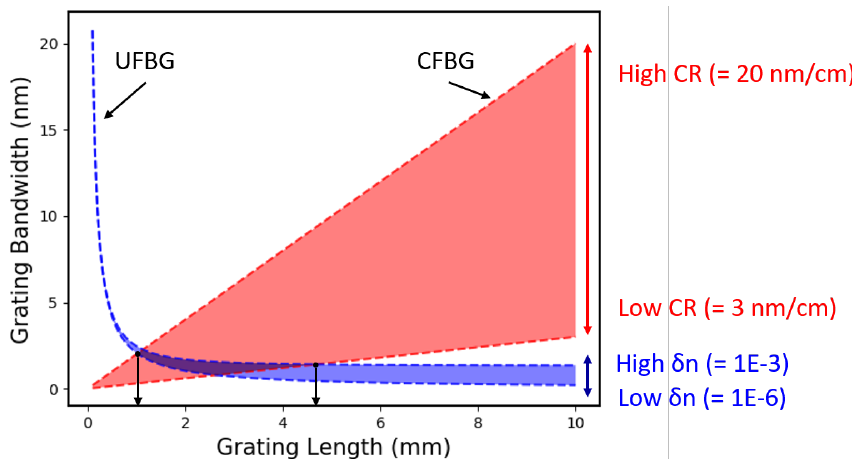
Figure 3. In blue: A plot of uniform grating bandwidth as a function of grating length over a range of index modulations. In red: S plot of chirped grating bandwidth over a range of chirp rates. For a CFBG with a specific chirp-rate and index modulation, the start of the non-linear region corresponds to the intersection of these two plots, where the CFBG transitions into a uniform